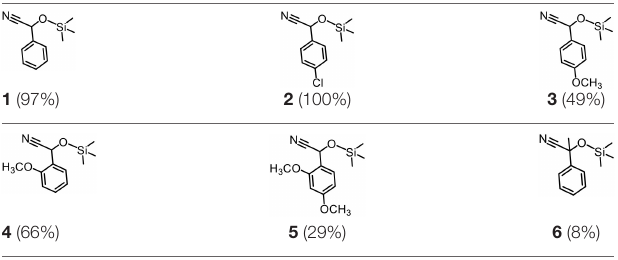
Frontiers in Chemistry |